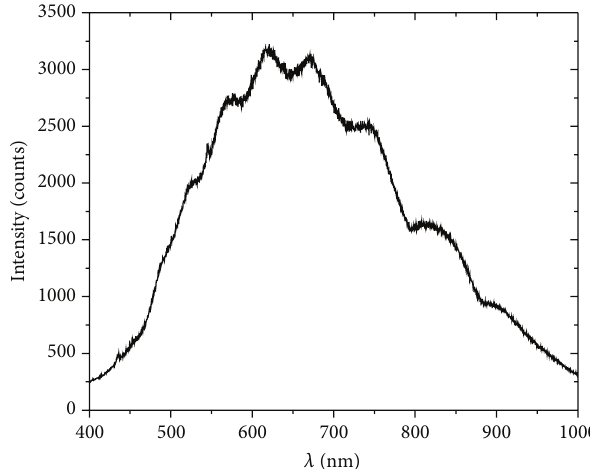
Figure 6: Emission spectrum of white light applied during excita- tion of